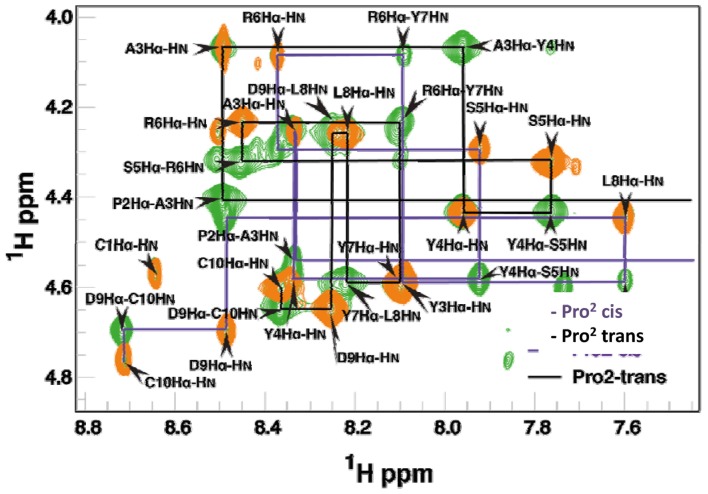
TOCSY (orange) and NOESY (green) of mupain-1-16.Assignments of the two isomeric forms is illustrated by connecting TOCSY Hα(i)-HN(i) and NOESY Hα(i)-HN(i+1) cross peaks with lines representing a shared reference commonly referred to as “backbone walks”.